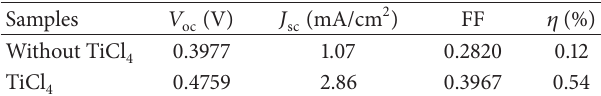
Table 1: The performance parameters of DSSCs with TiCl ment and without TiCl